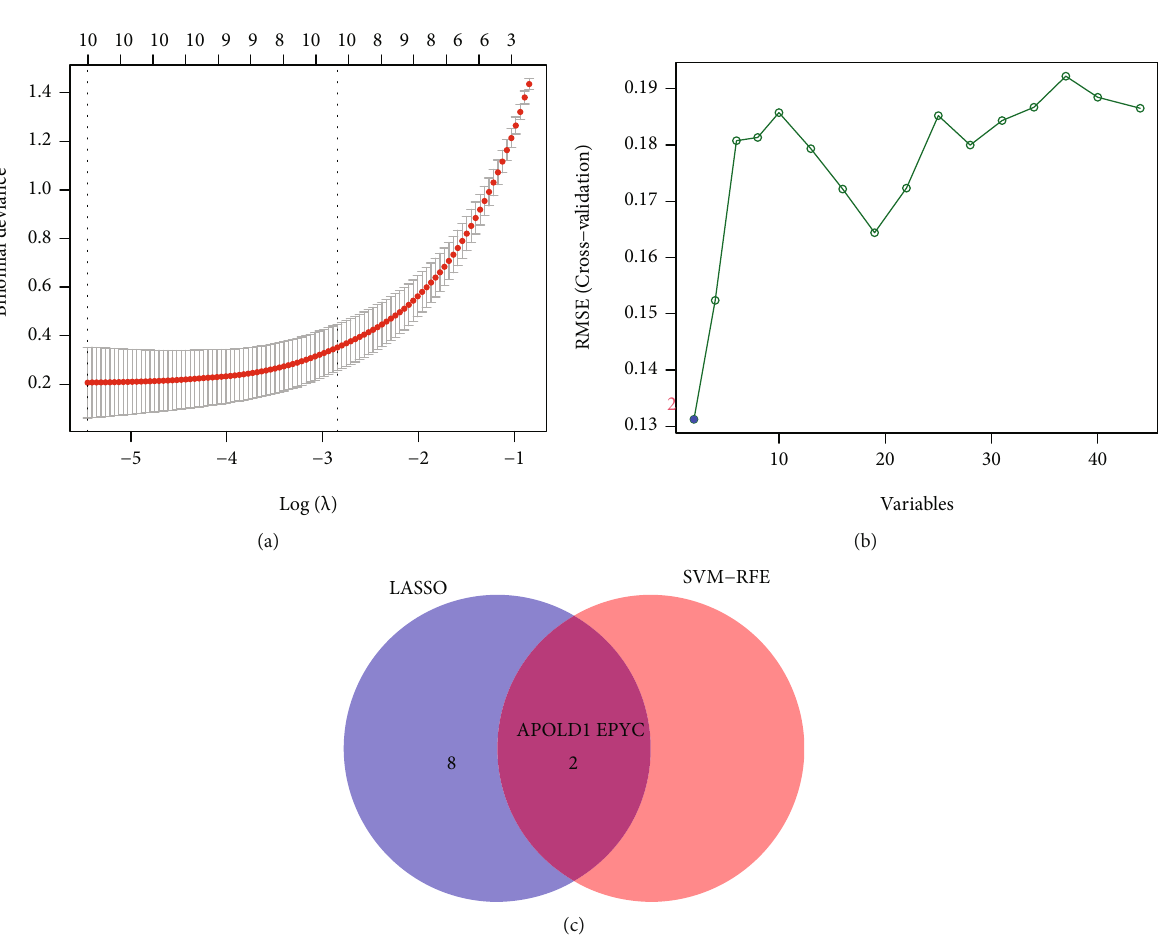
Figure 3: Selection of diagnosis marker candidates for OA: (a) tuning feature screening in the LASSO model; (b) a plot of biological marker screening via the SVM-RFE arithmetic; (c) Venn graph displaying 4 diagnosis biomarkers shared by LASSO and